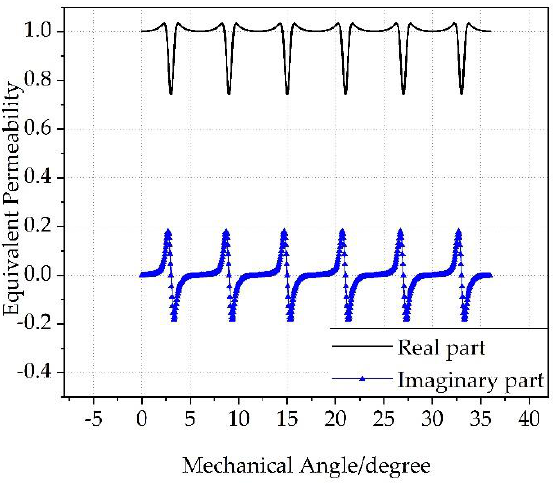
Figure 11. The real and imaginary parts of the complex relative magnetic conductance. Obviously, the relative magnetic permeability λ = λ a + j λ of slotless model satisfies λ a = 1, λ b = 0. b Due to the influence of the slot, the real and imaginary parts of the relative magnetic flux change at the corresponding positions of the